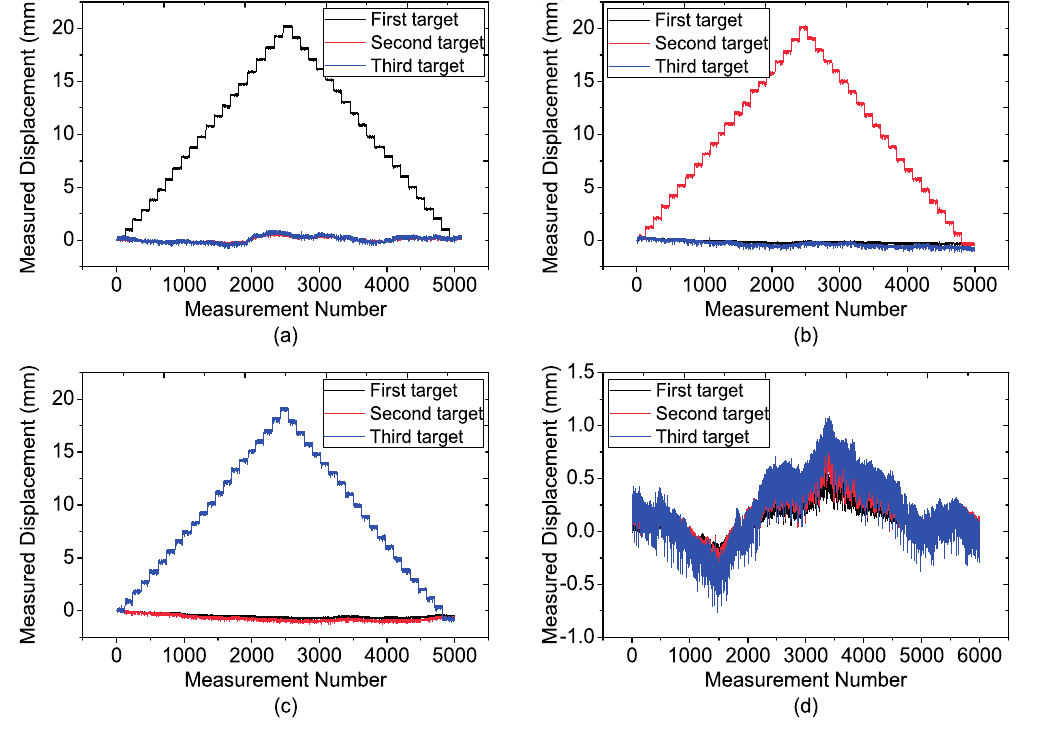
Figure 18. Measurement results of three targets for ( a ) Only the first target is moved; ( b ) Only the second target is moved; ( c ) Only the third target is moved; ( d ) All the targets keep